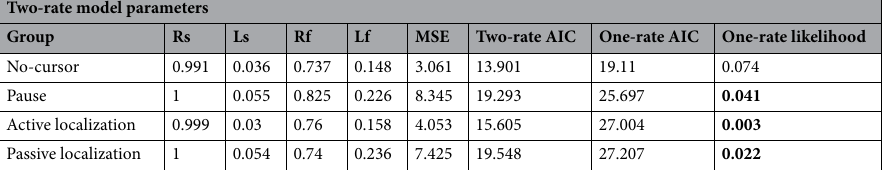
Table 2. Model parameters and goodness-of-fit estimates. All twoRate AIC’s are smaller than respective oneRate AICs indicating a better model fit from a two-rate model. Relative likelihoods below .05 are bolded. Parameter values could vary between 0 and 1,